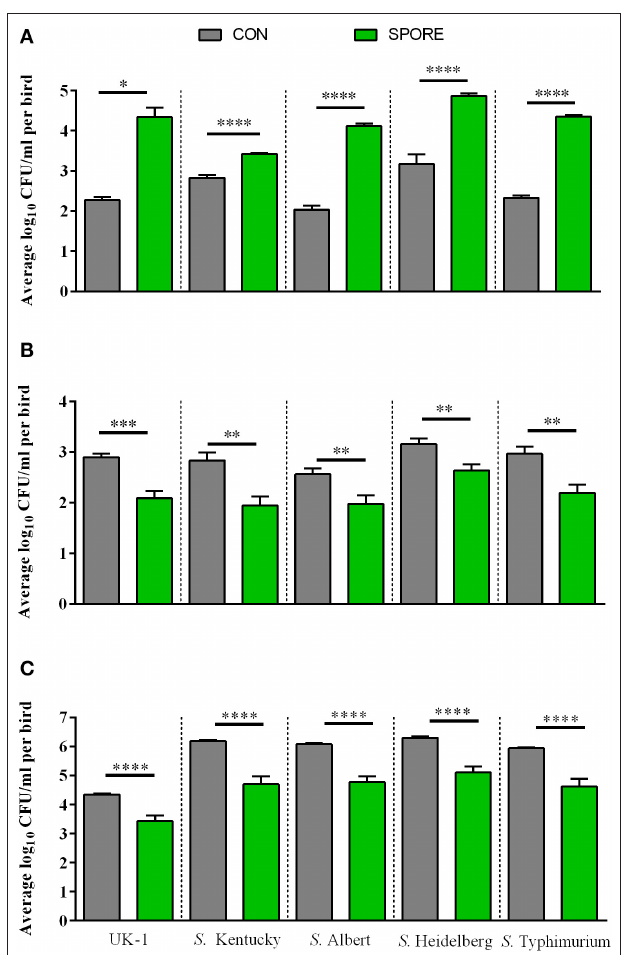
FIGURE 6 | Salmonella resistance assays in vitro . Salmonella enterica resistance was measured using in vitro bactericidal assays against multiple Salmonella isolates (summarized in Table 1 ). Salmonella killing was performed in small intestinal scrapings taken at 3 (A) , 7 (B) , and 14 dpi (C) in experimental